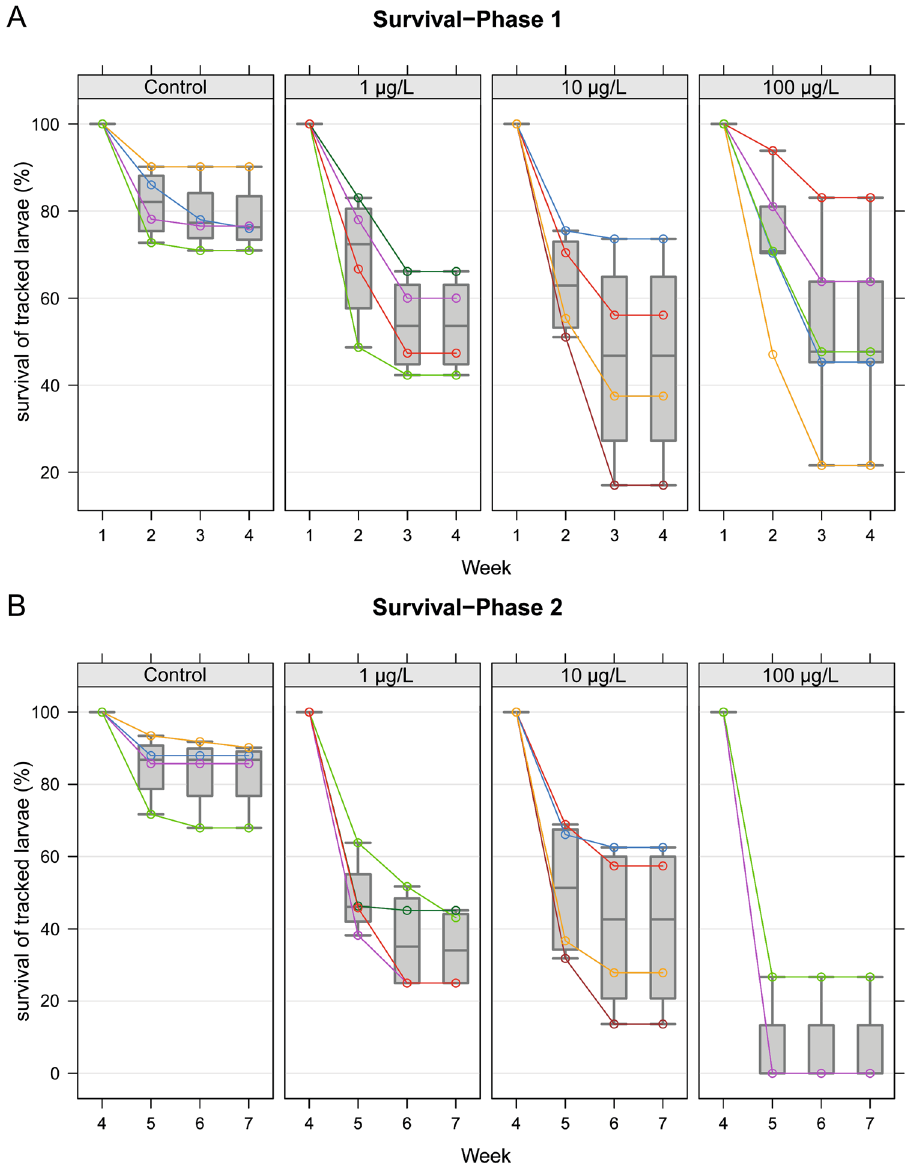
Figure 3. Survival of individually tracked larvae. Individually marked brood cells were tracked from the first larval stage (day 4–5 after egg laying) to emergence. ( A ) The percentage of brood surviving from week 1 to week 4 (survival phase A). Colonies exposed to clothianidin showed a reduced brood survival. Clothianidin exposure significantly affects brood survival (exposure-by-time interaction in mixed-effects ANOVA, P = 0.0293). One- sided tests for post hoc Dunnett contrasts yielded no significant P values in week 2, but in week 3 all clothianidin treatments showed significant differences (control vs. 1 µg/L, P = 0.0414; control vs. 10 µg/L, P = 0.0241; control vs. 100 µg/L, P = 0.0418). ( B ) The percentage of brood surviving from week 4 to week 7 (survival phase B). Clothianidin exposure reduced the number of surviving brood (exposure-by-time interaction in mixed effects ANOVA, P = 0.03776). One-sided tests for post hoc Dunnett contrasts in weeks 5 and 6: each clothianidin treatment has a significantly lower brood survival than the control group ( P < 0.0001 in all cases). Technical details of the analysis are provided in the supplementary statistical report, “Brood survival”